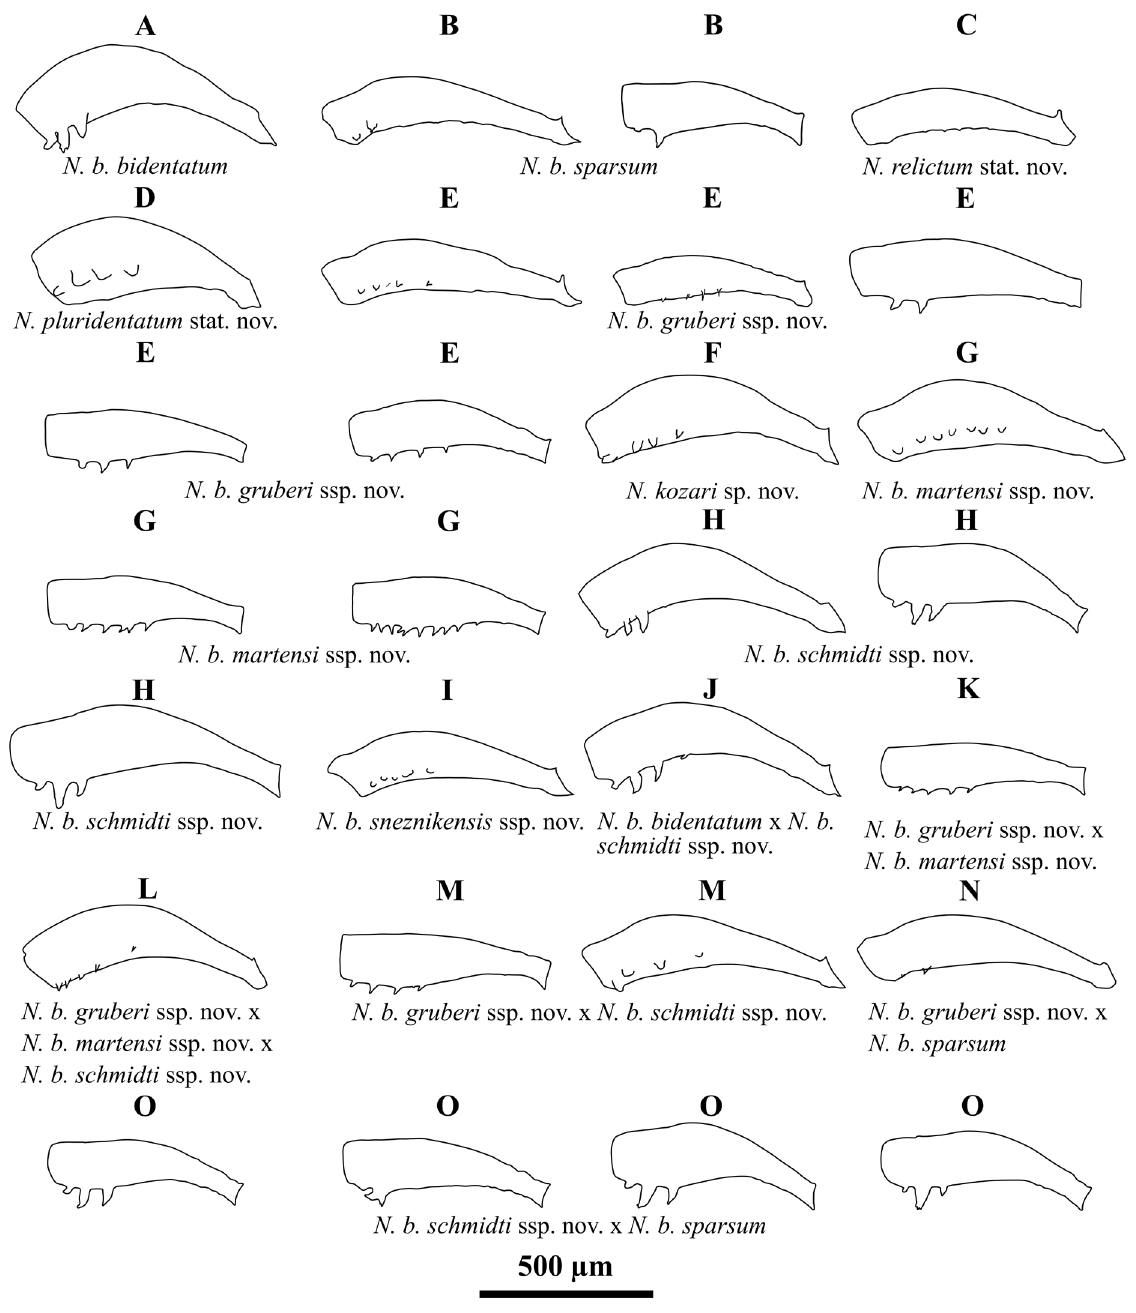
Fig. 10. Nemastoma bidentatum Roewer, 1914 complex, ♂♂. Variation of the Pa-Fe ( A–B first image, C , D–E first image, F–G first image; H–J , L–M right, N–O : lateral view; the others in dorso-medial view to show the